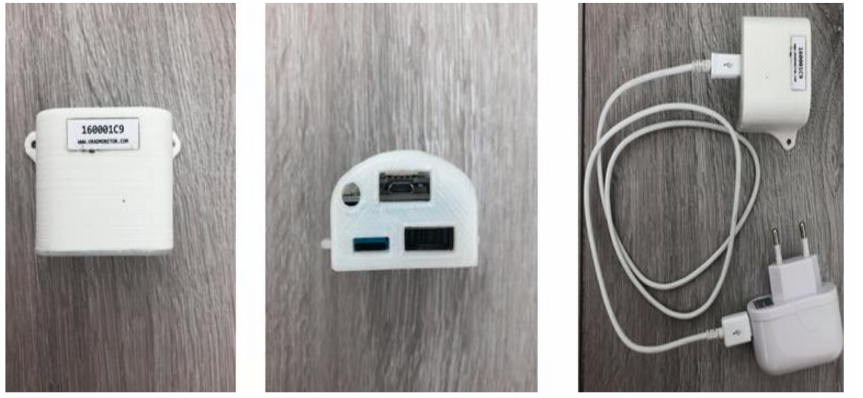
Figure 1. uRADMonitor